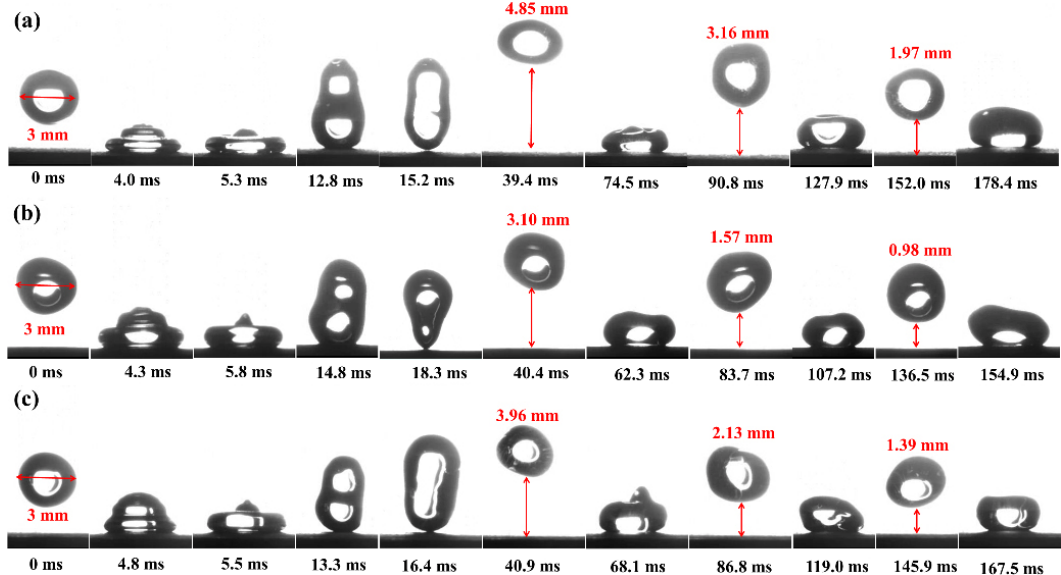
Fig. 3 Selected snapshots showing water droplet impacting on (a) decoupling, (b) nano, and (c) coupling coatings ( v = 0.44